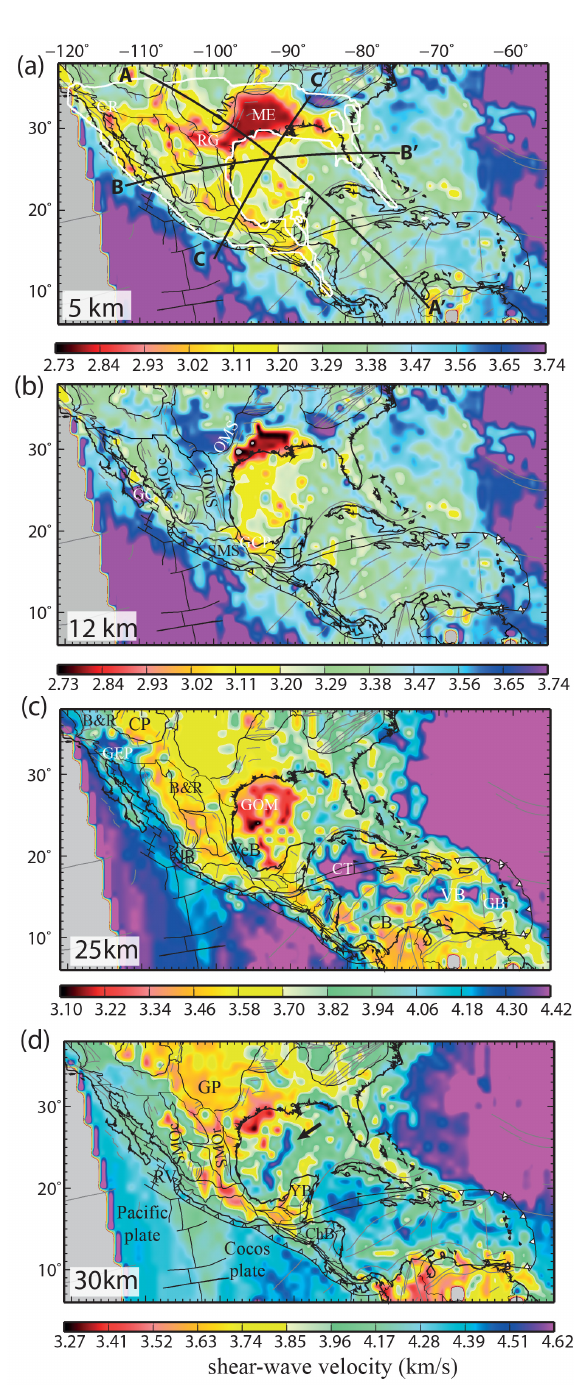
Figure 9. Shear wave velocity maps at different depths ( (a) 5, (b) 12, (c) 25, and (d) 30km). Faults, ridges, fracture zones, and basin limits are denoted as gray lines (CGMW/UNESCO, 2000). (a) Thick black lines indicate the cross-sections shown in Fig. 10 and the white line contours the area with ANT resolution equal to or lower than 250km at 10s period. B&R denotes Basin and Range; CB Colombian Basin; ChB Chortis Block; CP Colorado Plateau; CR Colorado River; CT Cayman Trough; GB Grenada Basin; GCP Gulf Coastal Plain; GEP Gulf Extensional Province; GOM Gulf of Mexico; GP Great Plains; IT Isthmus of Tehuantepec; JB Jalisco Block; ME Mississippi Embayment; OMS Ouachita–Marathon–Sonora orogenic belt; RG Rio Grande; RV Rivera Plate; SMOc Sierra Madre Occidental; SMOr Sierra Madre Oriental; SMS Sierra Madre del Sur; TMVB Trans-Mexican Volcanic Belt; VB Venezuela Basin; VeB Veracruz Basin; and YB Yucatan